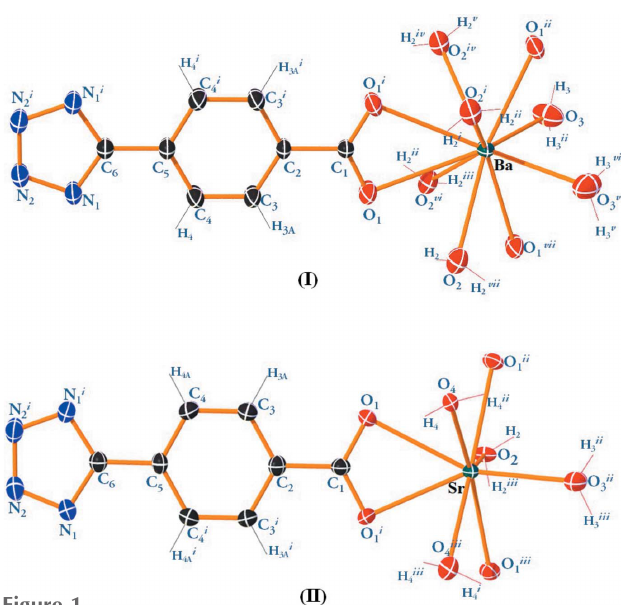
Figure 1 The coordination environment of the Ae 2+ ion in compounds (I) and (II), showing the atom-numbering scheme. Displacement ellipsoids are drawn at the 50% probability level. [Symmetry codes for (I): (i) 2 (cid:4) x , 1 (cid:4) y , 1 (cid:4) z ; (iii) x (cid:4) 1 (cid:4) y , 1 (cid:4) z ; (iv) 2 (cid:4) x , y , z ; (v) 1 (ii) 1 + x , 1 , 1 2 2 2 2 2 2 (vi) x (cid:4)